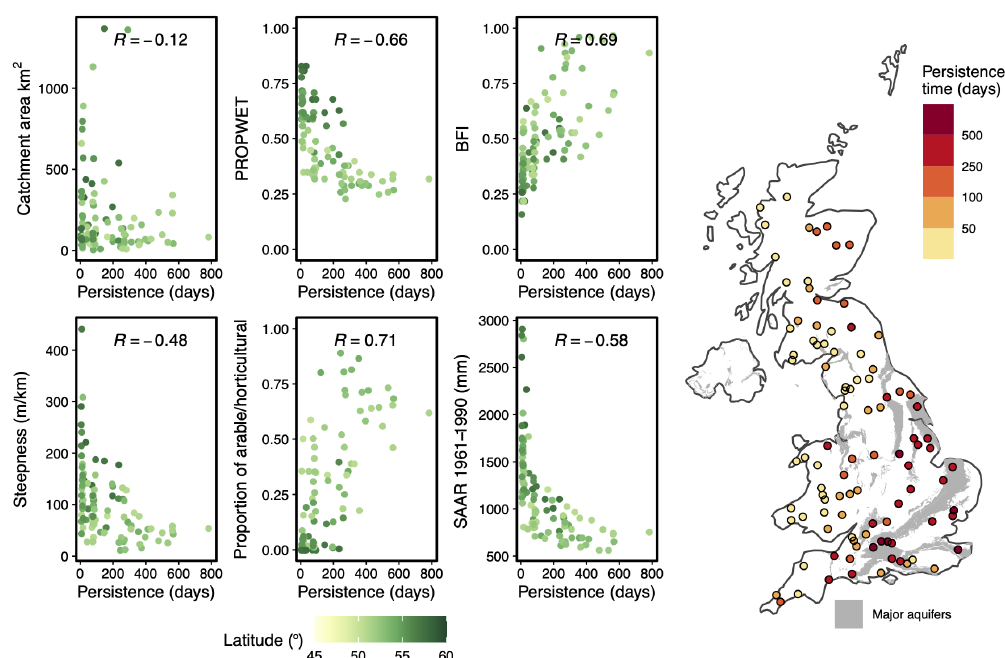
Figure 7. (a) Relationship between the persistence time (d) of the 6-month precondition storyline (100-year return period) with selected catchment characteristics. (b) Spatial variation in persistence time for the selected